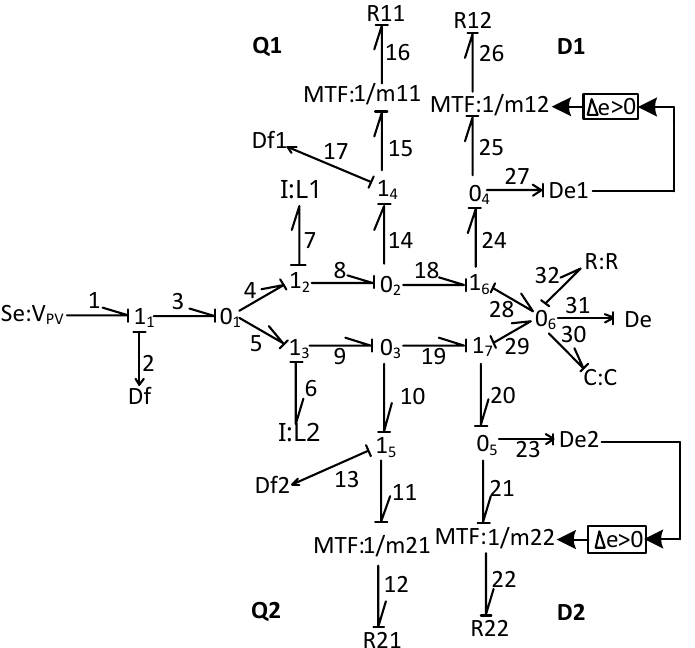
Figure 9. Bond graph model of the 2IBC in derivative